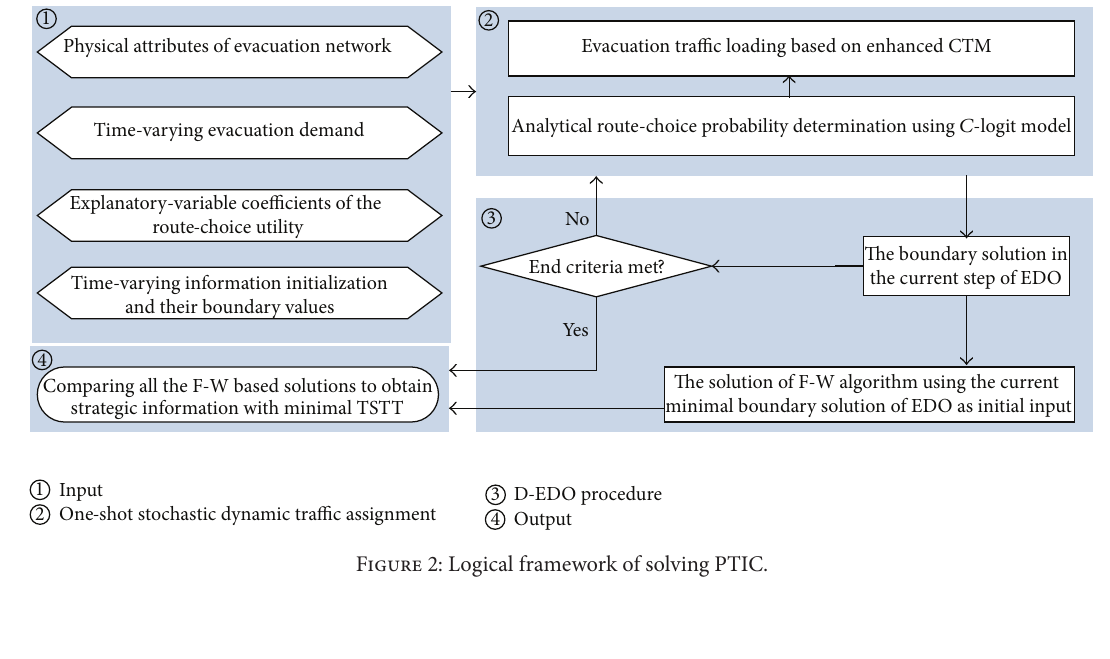
Figure 2: Logical framework of solving